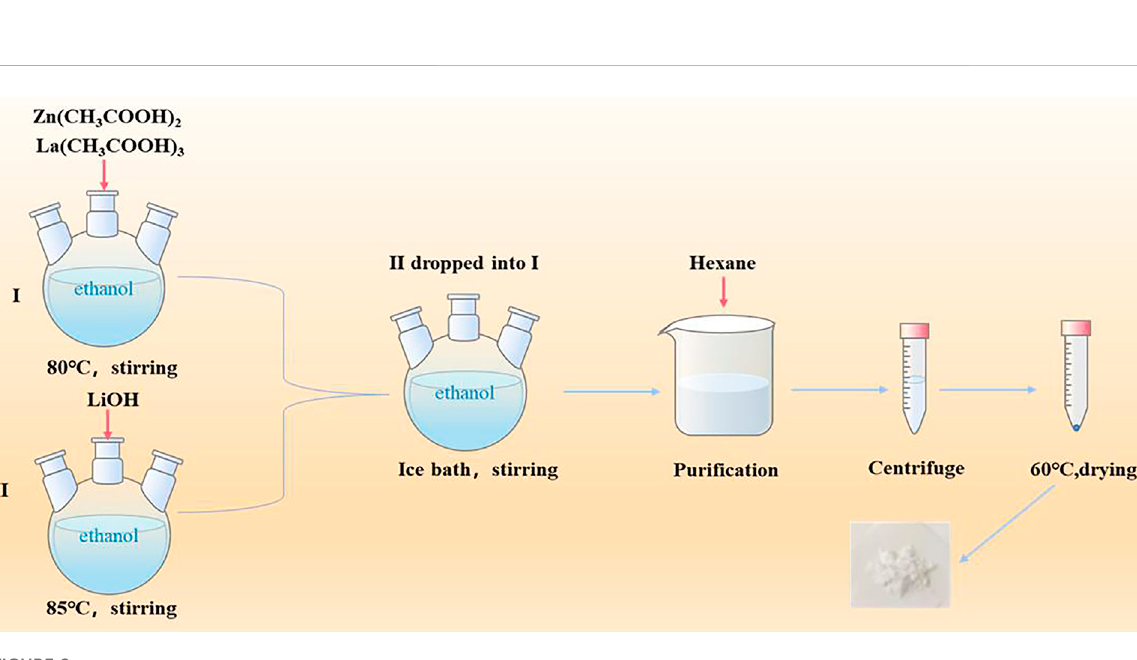
FIGURE 2 Synthesis process of pure and La doped ZnO